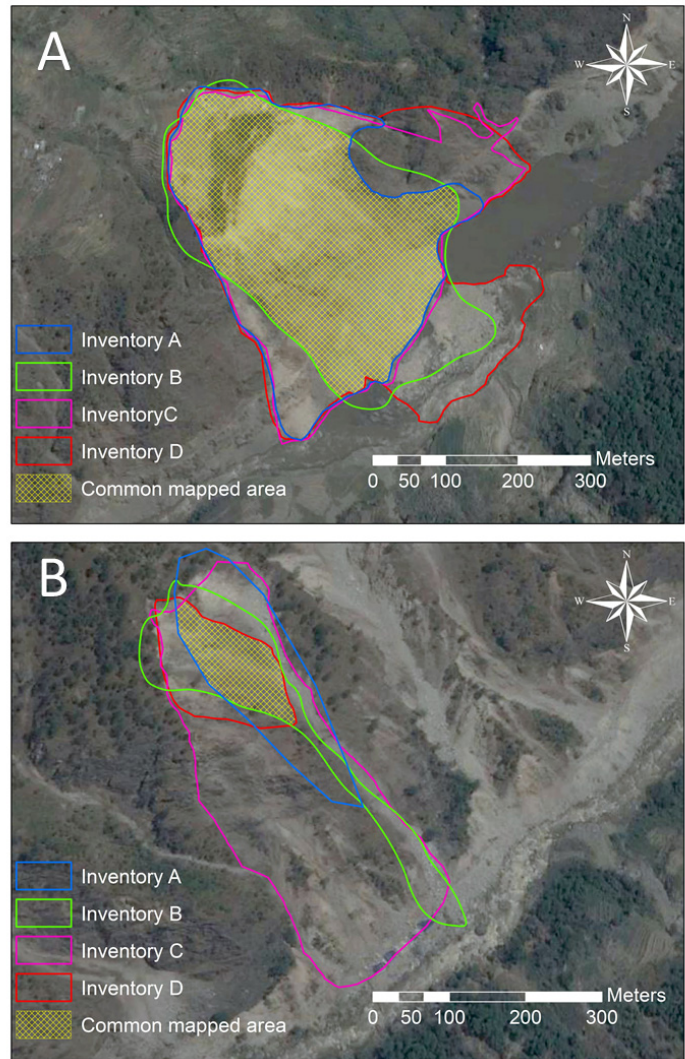
Figure 5. Mapping by different interpreters for the Gorkha earthquake of the same landslides. ( A , B ) represent examples of the mapped landslides. Geosciences 2019 , 9 , 437 10 of 19